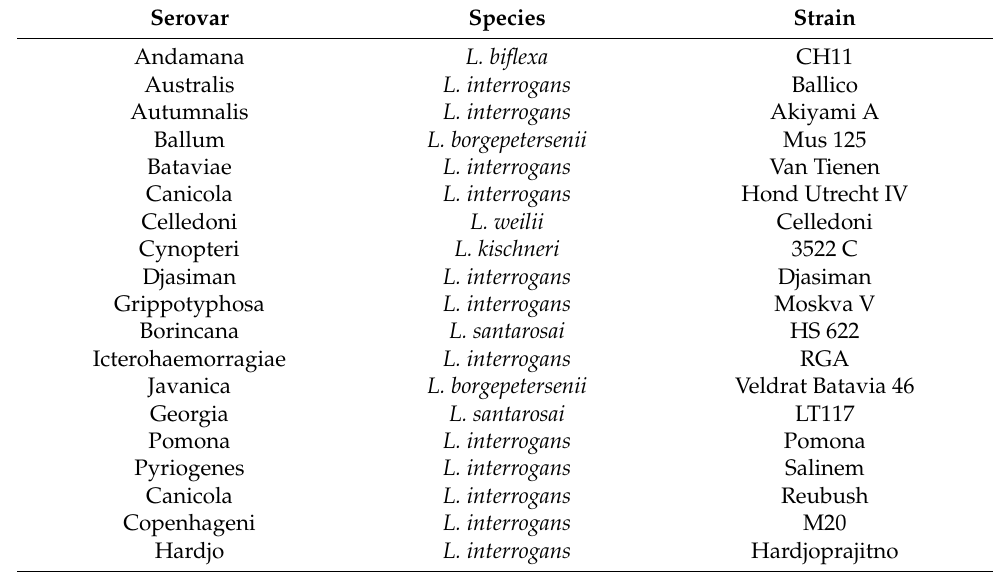
Table 1. List of the 19 Leptospira serovars used in the MAT to detect anti- Leptospira antibodies in sera obtained from native